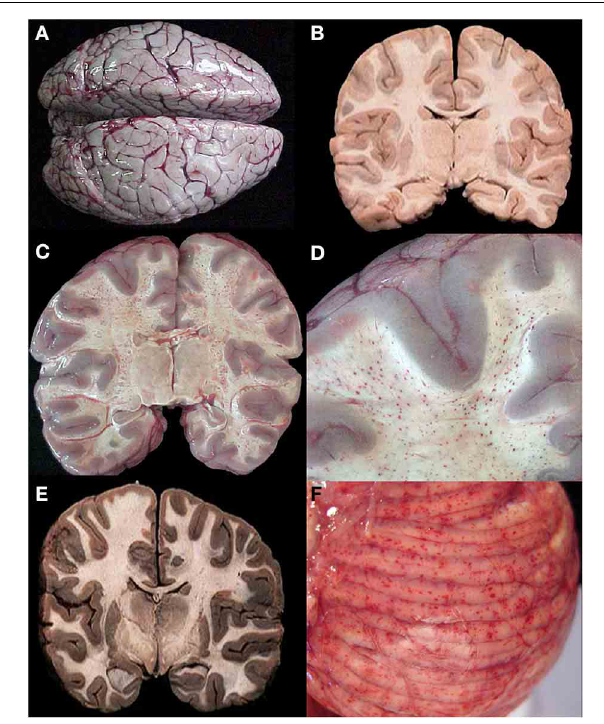
FIGURE 2 | A summary of representative images from the gross examination of the brain in the autopsy series is shown for CM cases. The vast majority of cases, regardless of diagnosis, showed brain swelling with flattened gyri and narrowed sulci (A) . In this example, the brain has the classic “slate gray” to “purple” appearance of CM which is possibly due to malaria pigment within vessels. In all control cases and in a subset of the CM1 cases, the coronal brain slice appeared without discoloration (B) . In the classic CM2 appearance, petechial hemorrhages are seen diffusely in the white matter throughout the brain (C) . A higher magnification demonstrates the abrupt transition from white to gray matter and the lack of hemorrhages in the gray (D) . In a subset of the CM1 cases, the coronal brain slice appeared very discolored (an unexplained phenmenon) and swollen but without petechial hemorrhages in the cerebral cortex (E) . The cerebellum had petechial hemorrhages in both the gray and white matter and thus, visible on the surface grossly (F) . (B,E) Were previously published in part in the Journal of Infectious Diseases (2005) and appear here with express permission (see Milner et al., 2005; White and Silamut, 2005).